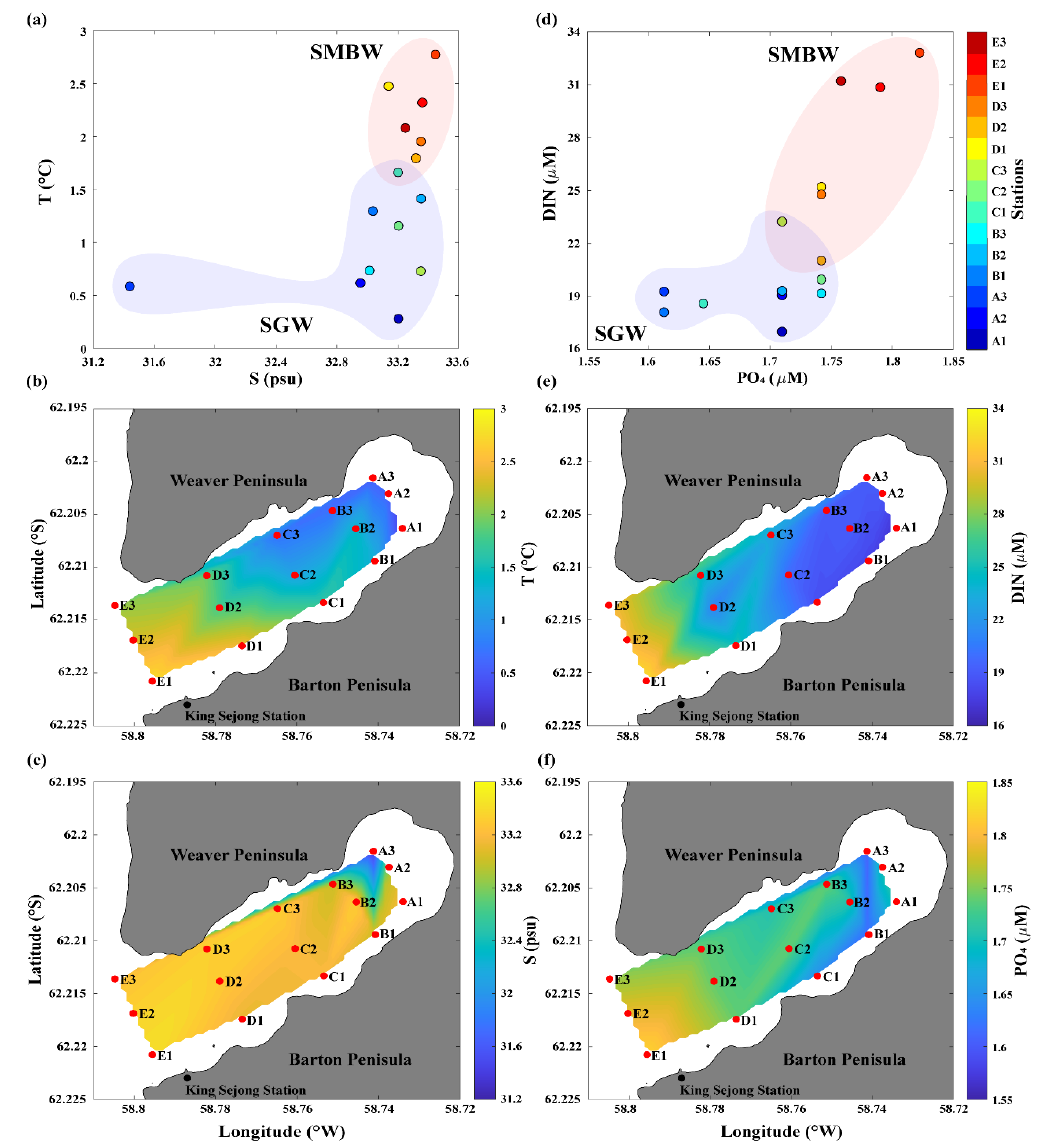
Figure 2. Physical and biogeochemical properties of the Marian Cove surface waters during the summer of 2018: ( a ) temperature (T) – salinity (S) diagram, spatial distribution of ( b ) T and ( c ) S, ( d ) dissolved inorganic nitrogen (DIN)‒phosphate (PO 4 ) plot, and the surface distribution of ( e ) DIN and ( f ) PO 4 . Gammaproteobacteria (mean: 41%), unclassified Bacteroidetes (mean: 35%),